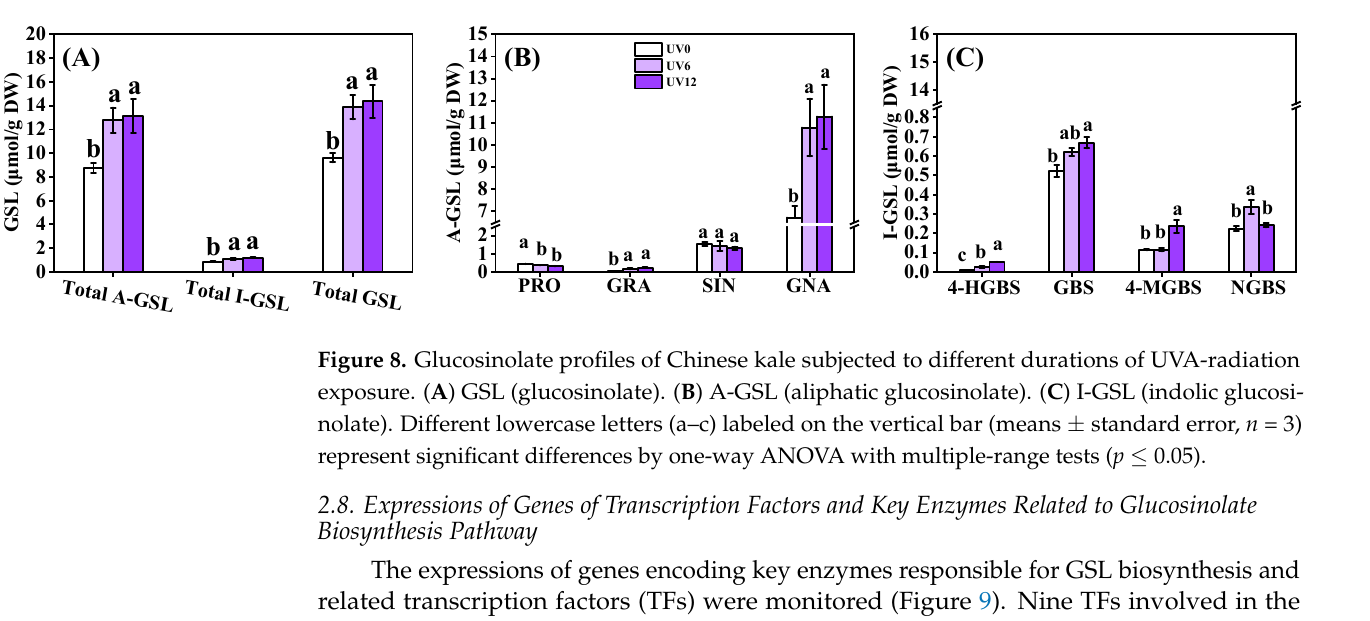
Figure 7. The composition of GSLs in Chinese kale. PRO (Progoitrin), GRA (Glucoraphanin), SIN (Sinigrin), GNA (gluconapin), 4-HGBS (4-hydroxy-glucobrassicin), GBS (Glucobrassicin), 4-MGBS (4-methoxy-glucobrassicin) and NGBS (Neoglucobrassicin).